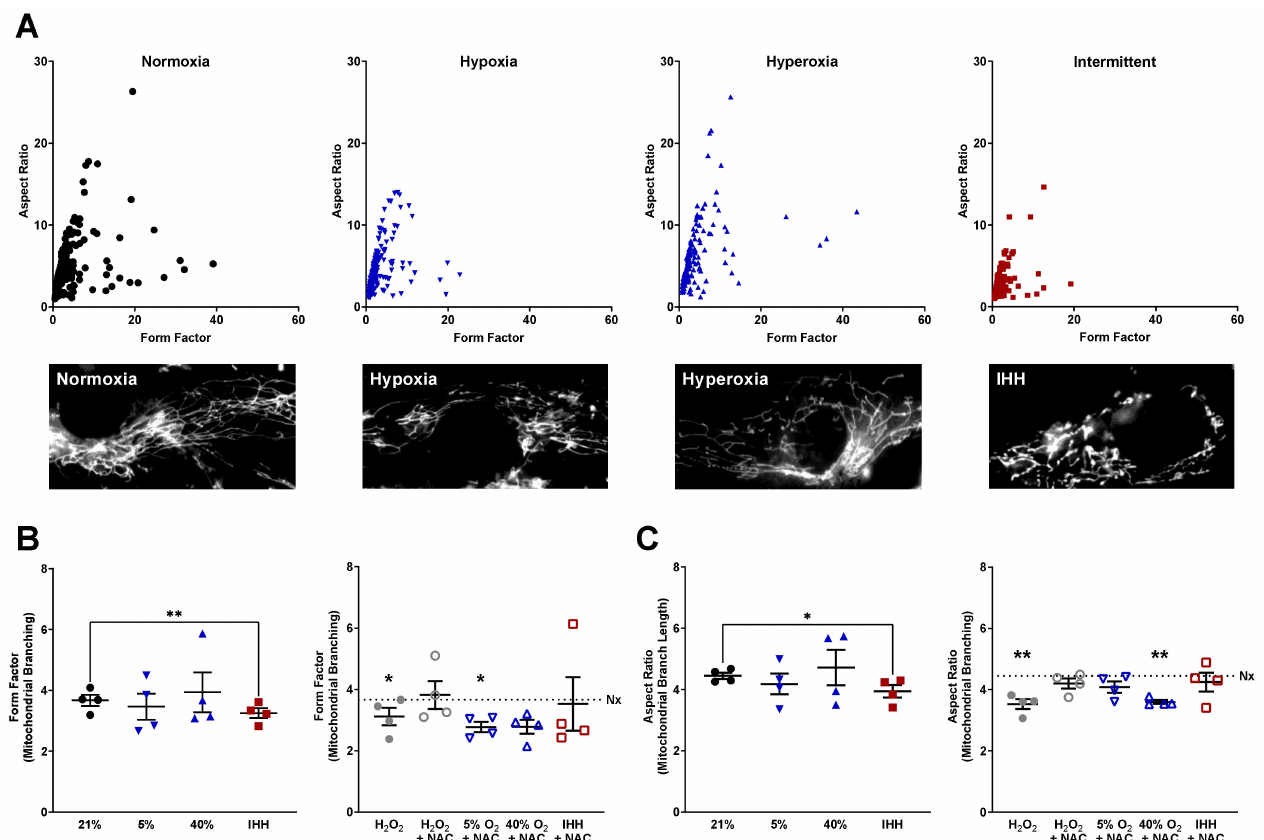
Figure 2. Mitochondrial morphology in fASM exposed to normoxia, hypoxia, hyperoxia, or IHH with or without the antioxidant NAC. Human fASM were exposed to either 5% O 2 , 21% O 2 , 40% O 2 , or IHH with or without NAC for 24 h prior to staining with MitoTracker Green FM. A subset of fASM in normoxia was exposed to H 2 O 2 or H 2 O 2 + NAC for two hours prior to staining with MitoTracker Green as a positive control. Cells were visualized using a Keyence microscopy system. ImageJ was used to select individual cells for analysis using a MitoMorph macro and Image J to determine form factor (mitochondrial branching) and aspect ratio (mitochondrial branch length). ( A ) Representative scatter plots of form factor and aspect ratio with representative microscopy images shown of fASM from either 21% O 2 , 5% O 2 , 40% O 2 , or IHH. ( B ) Form factor and ( C ) aspect ratio were measured and analyzed by a MitoMorph macro and Image J. Horizontal dotted lines represent the normoxia control. Data were analyzed using t-tests: * p < 0.05; ** p < 0.01. Data are represented as mean ± SEM ( n = 4 fASM patient lines per condition per